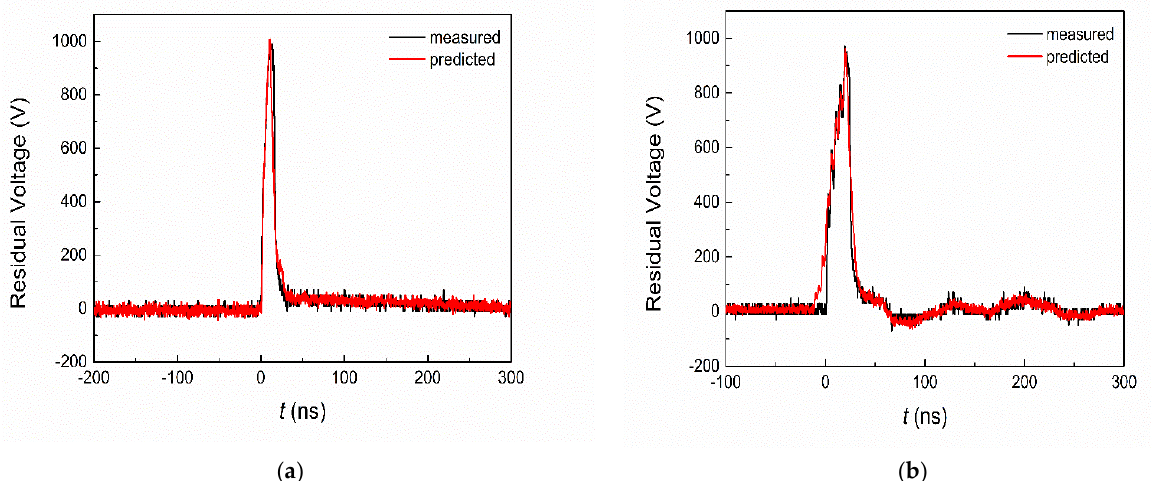
Figure 4. The prediction waveform vs. the measured waveform of residual voltage: ( a ) The prediction of GDT’s response of 1MHz at the current injection level of 85%; ( b ) The prediction of GDT’s response of 5.6MHz at the current injection level of 85%.